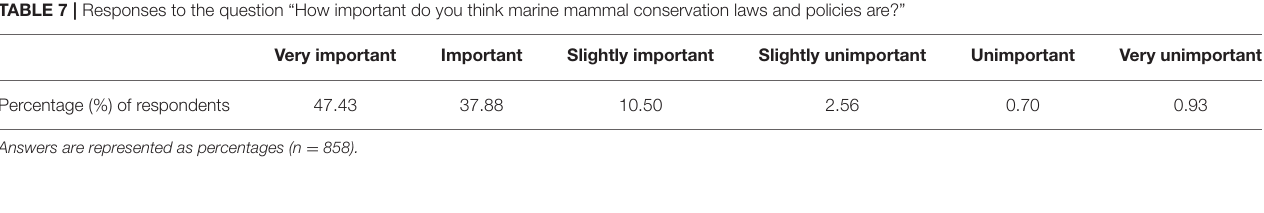
TABLE 8 | Responses to the question “How well do you think dolphin and whale species are protected worldwide?” Overprotected